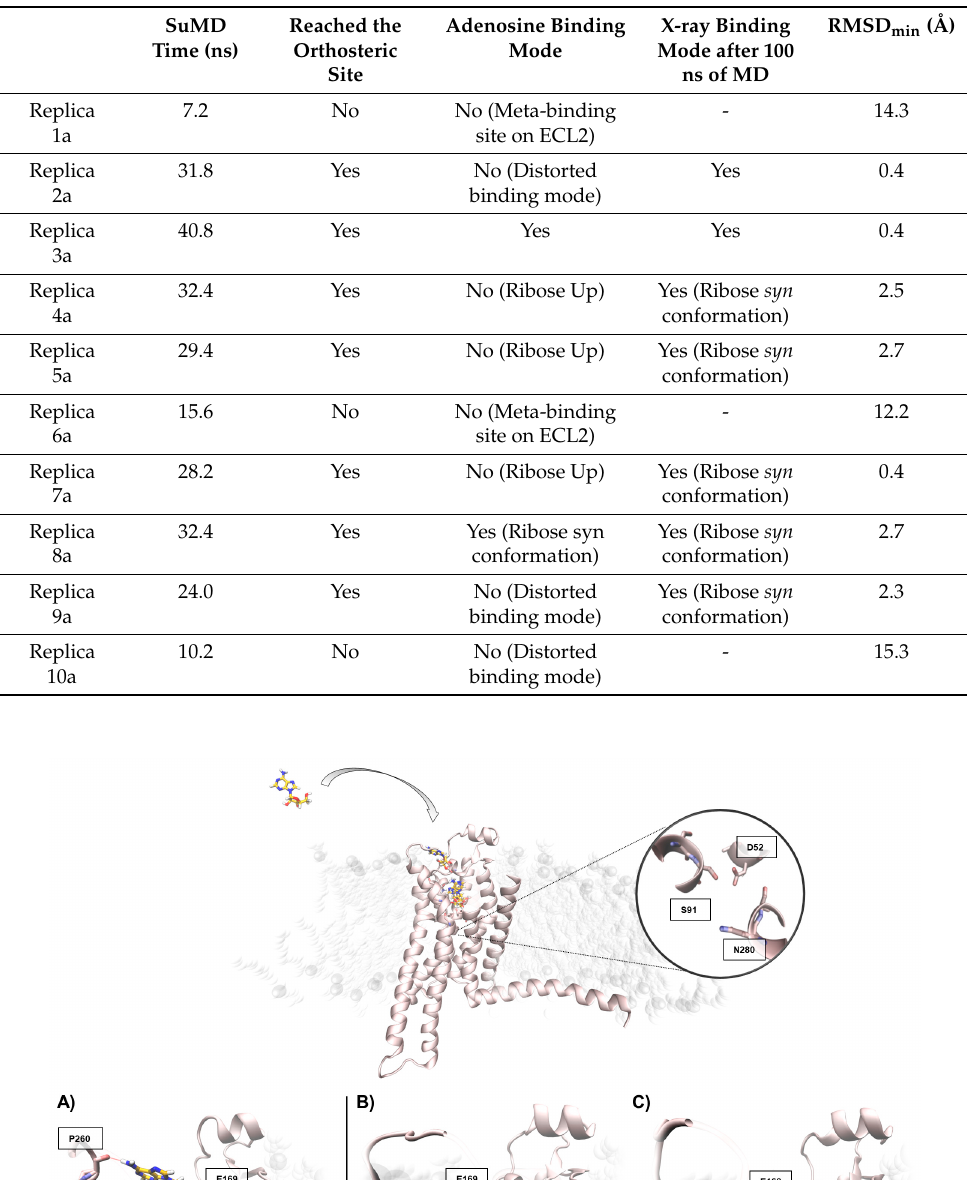
Table 3. Summary of the adenosine SuMD simulations performed on the A 2A AR intermediate-active conformation. For each replicate, the SuMD simulation time required, the positive or negative outcome, and the binding mode sampled at the end are reported along with the RMSDmin (calculated using 2YDO as a reference). MD = molecular dynamics.